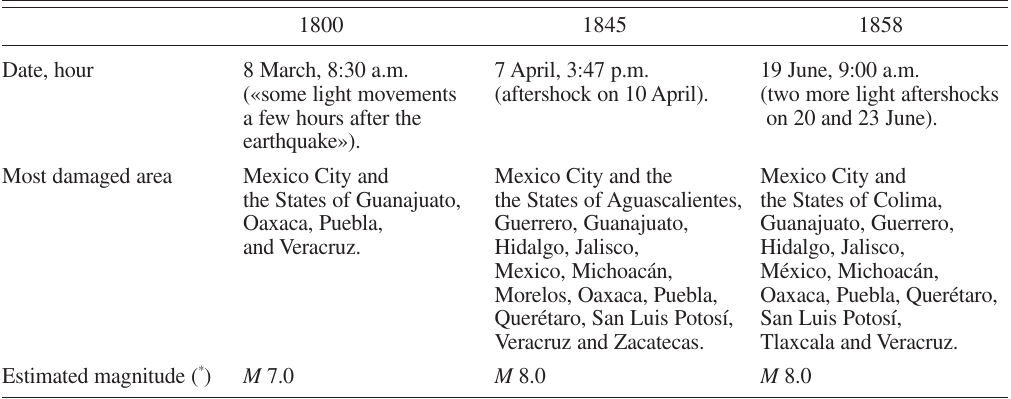
Table I. Main data for the 1800, 1845 and 1858